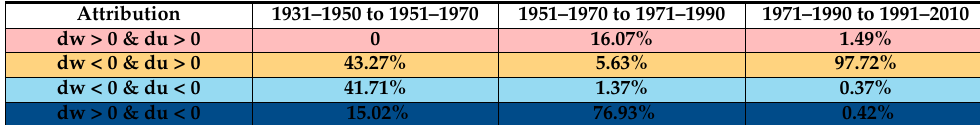
Table 1. This table quantifies the results presented in Figure 4 in terms of the respective areas (in percent) affected by the changing climate and land